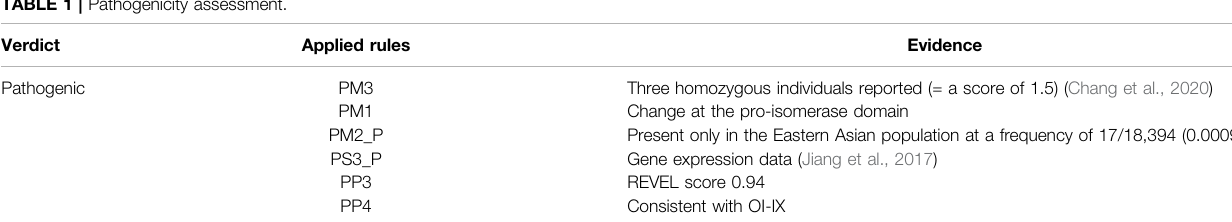
TABLE 1 | Pathogenicity